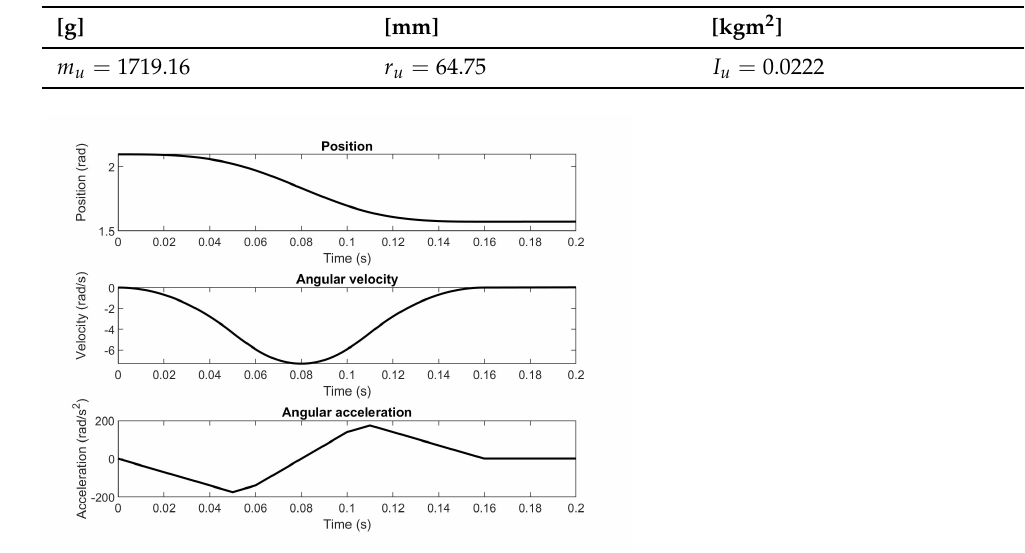
Table 3. Parameter values of the unbalanced rotatable manipulator including the inertia of the actuator.